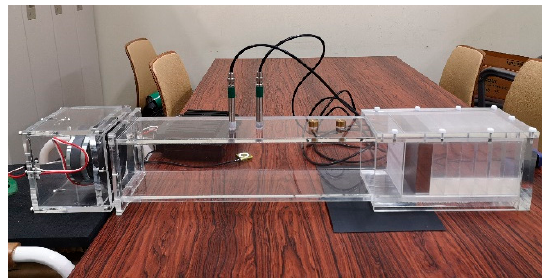
Figure 5. Experimental setup with an impedance tube.